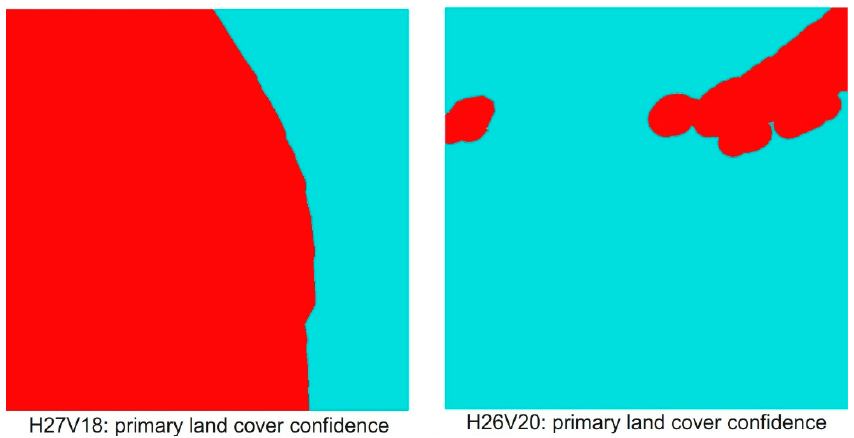
Figure 4. The primary land cover confidence of two outlier tiles. Red means no stable time series models were produced for this pixel, so the land cover classes of translated NLCD 2001 were used. Cyan represents the ocean.